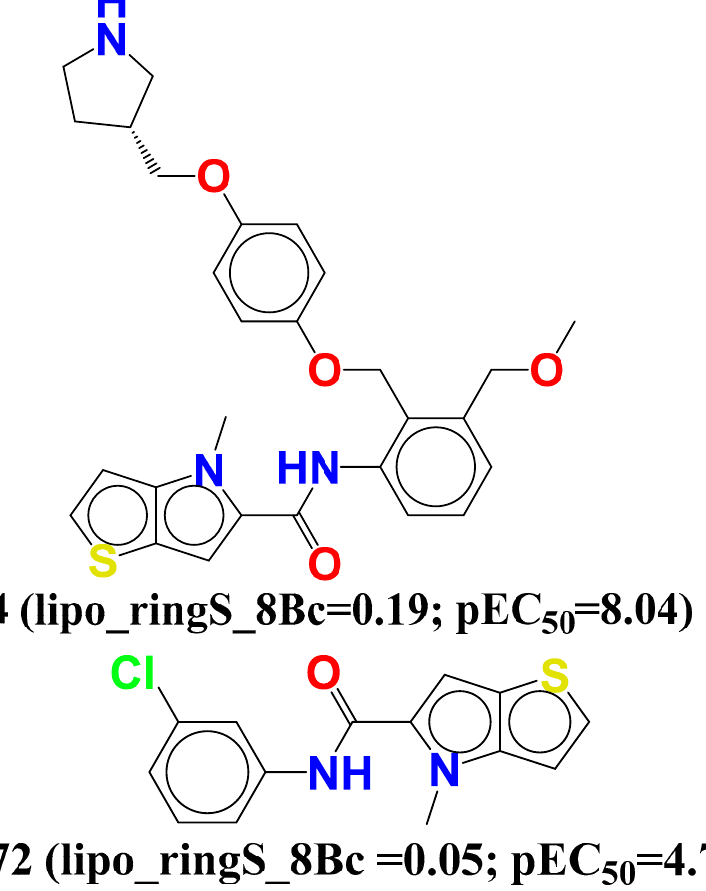
Figure 6. Depiction of molecular descriptor lipo_ringS_8Bc for the molecules 4, 72, and reported molecule 28186757 only.